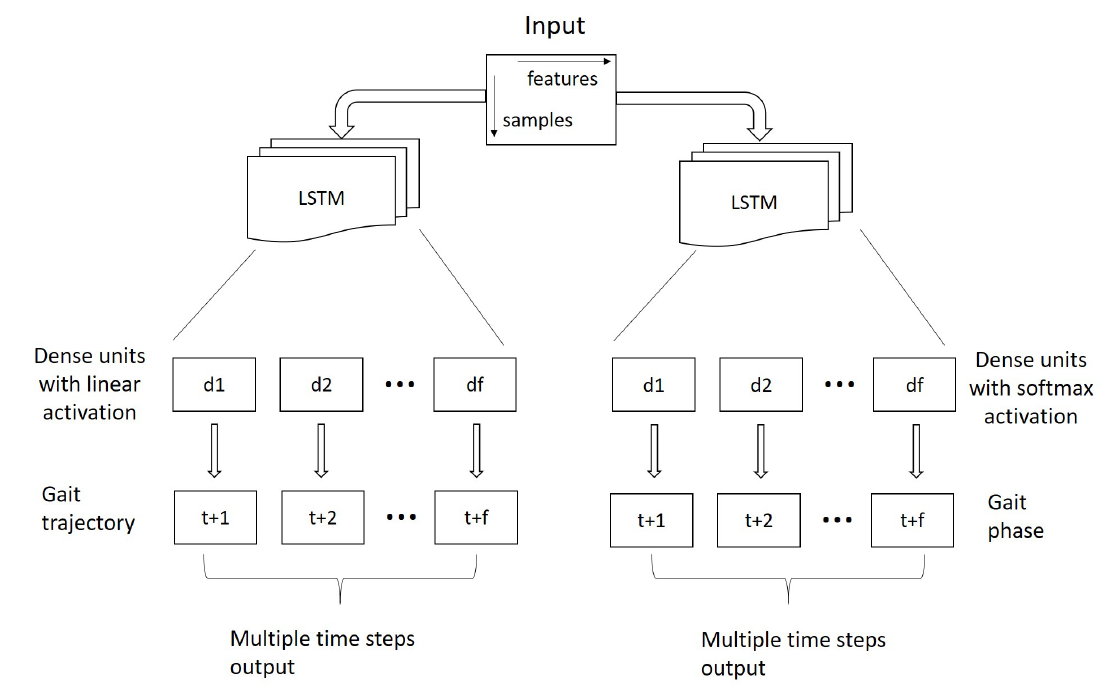
Figure 1. Implemented long-short term memory (LSTM) architecture for multiple-frame output of gait trajectory and